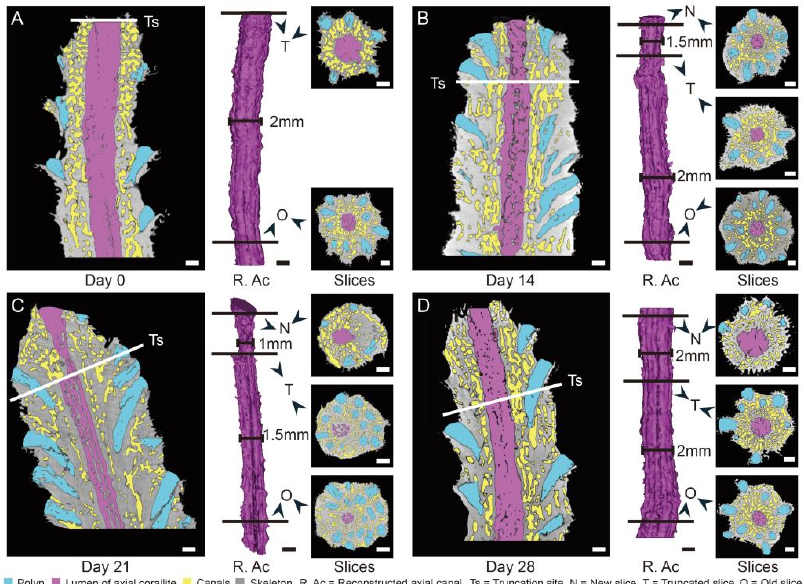
Figure 4. Three-dimensional reconstructions revealing calcium transport along the axial canal under the truncated branch rebuilding process in A. muricata . ( A ) In 0-day samples, the columnar lumen had a few calcium carbonate deposition scattered inside it, and the cross-sectional diameter of lumen in the axial corallite was about 2.0 mm. ( B ) In 14-day samples, the volume of calcium carbonate deposition within the lumen was increased. The cross-section diameter of the newborn part of the lumen was about 1.5 mm, thinner than the older part. ( C ) In 21-day samples, the calcium carbonate deposition increased and occupied nearly half of the lumen. The cross-section diameter of the lumen was about 1.0 mm in the newborn part, and 1.5 mm in the older part. ( D ) In 28-day samples, there were fewer calcium carbonate depositions left in the axial canal, and the cross-sectional diameter of the lumen was similar to the day 0 group. Scale bars: 1 mm.